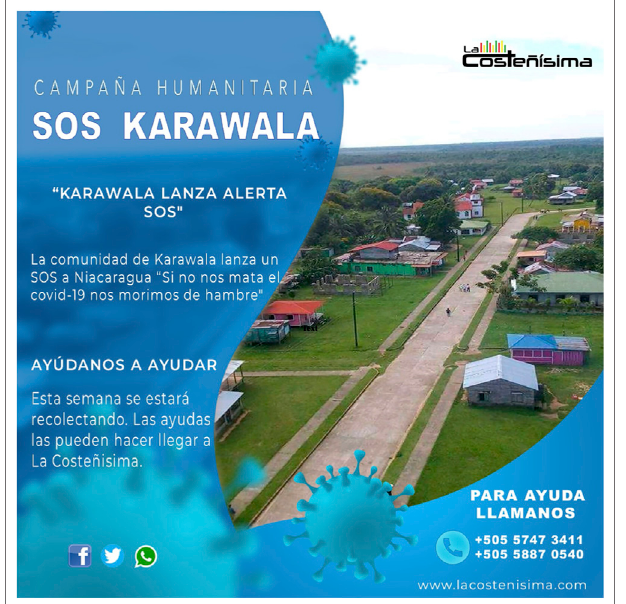
FIGURE1| Callforasolidaritycollectionofmedicalsuppliesandfoodfor the Karawala community, organized by the Community and local radio La Costeñísima. Source: 100% Noticias (2020c).